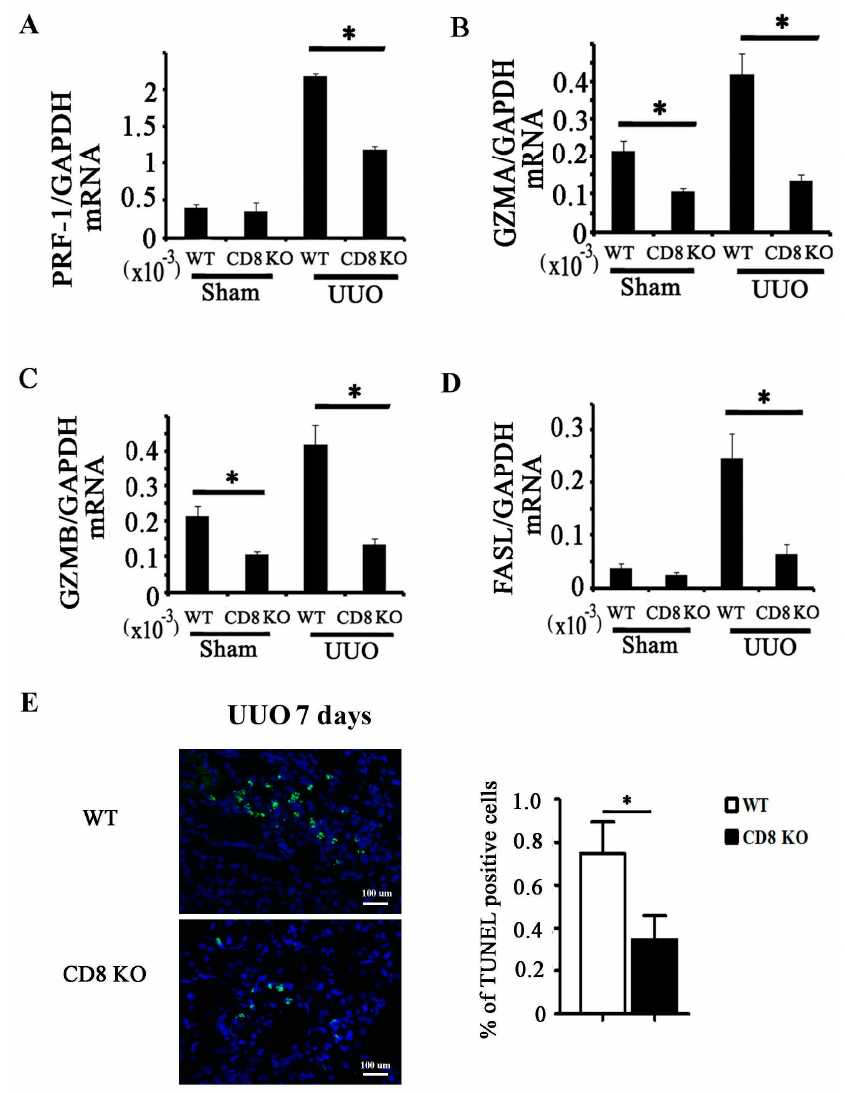
Figure 3. CD8 KO reduces cytotoxicity and cell apoptosis in obstructed kidney. ( A – D ) mRNA expression levels of PRF-1, GZMA, GZMB, and FASL in whole kidney tissues were analyzed by quantitative RT-PCR (* p < 0.05, CD8 KO vs. WT; n = 5); ( E ) TUNEL staining is performed in kidney; TUNEL (green), nucleus (blue). The percentage of TUNEL-positive cells in total cells is calculated ( n = 5, * p < 0.05).